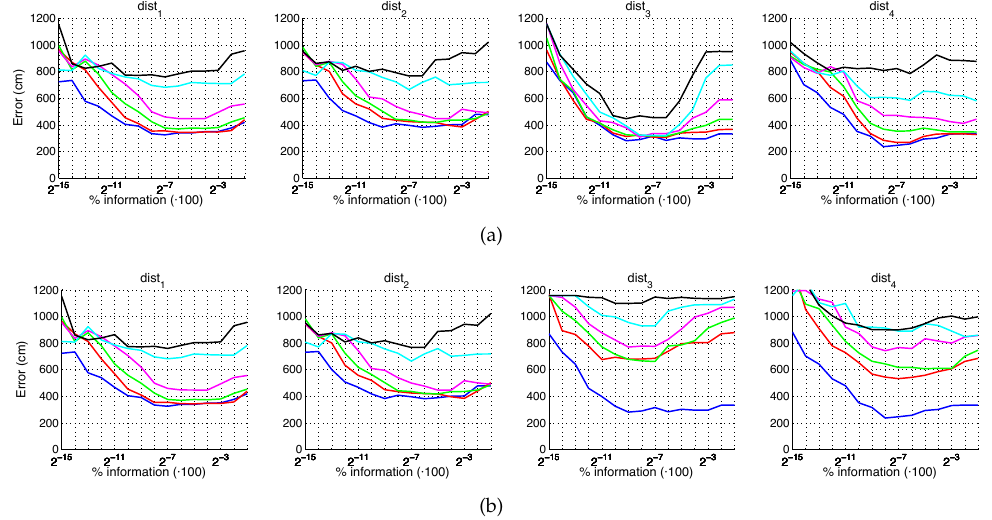
Figure 24. Gist average localization error with noise: ( a ) no filter and ( b ) homomorphic